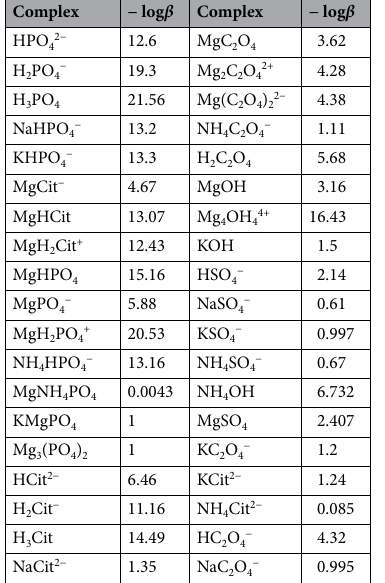
Table 7. Stability constants –log β of chemical complexes which are taken into account in the analysis. The presented stability constants are calculated using computer code EQUIL 36 at 37 °C.